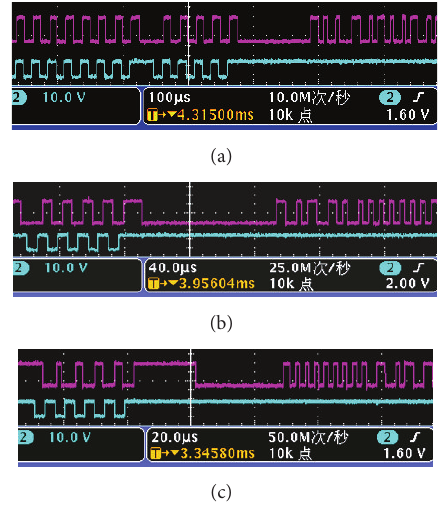
Figure 12: Measured waveform of the reader and tag: pink color (top) is tag reflected signal, and blue color (bottom) is reader com- mand. (a), (b), and (c) are 40kbps, 80kbps, and 160 kbps data